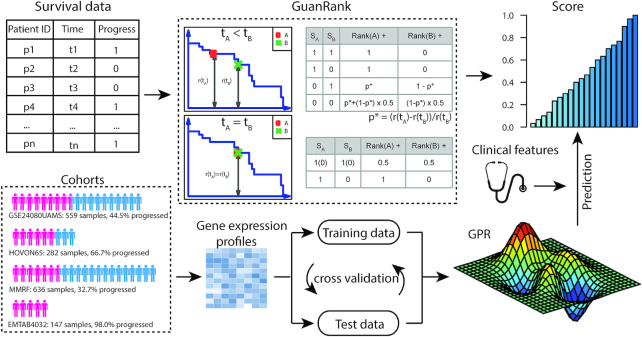
Overall workflow of the algorithm design to predict the progression of patients with MM. The original survival data were first converted into complete ranking scores via GuanRank. Four different cohorts were used to train models for predicting MM progression based on gene expression profiles and clinical features. The GPR method was used in our final model to achieve the best prediction performance.